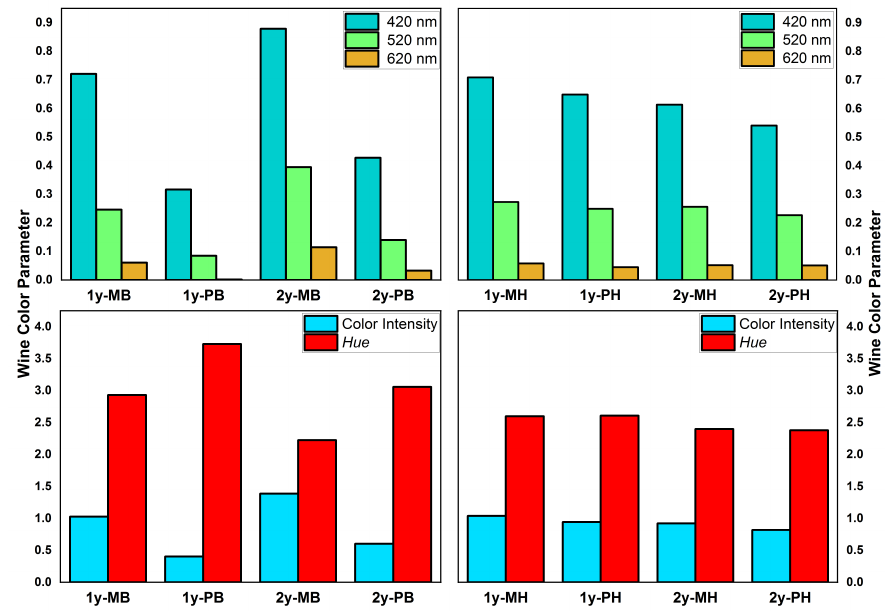
Figure 6. Colour parameters, C.I. and hue, for the untreated and plasma treated